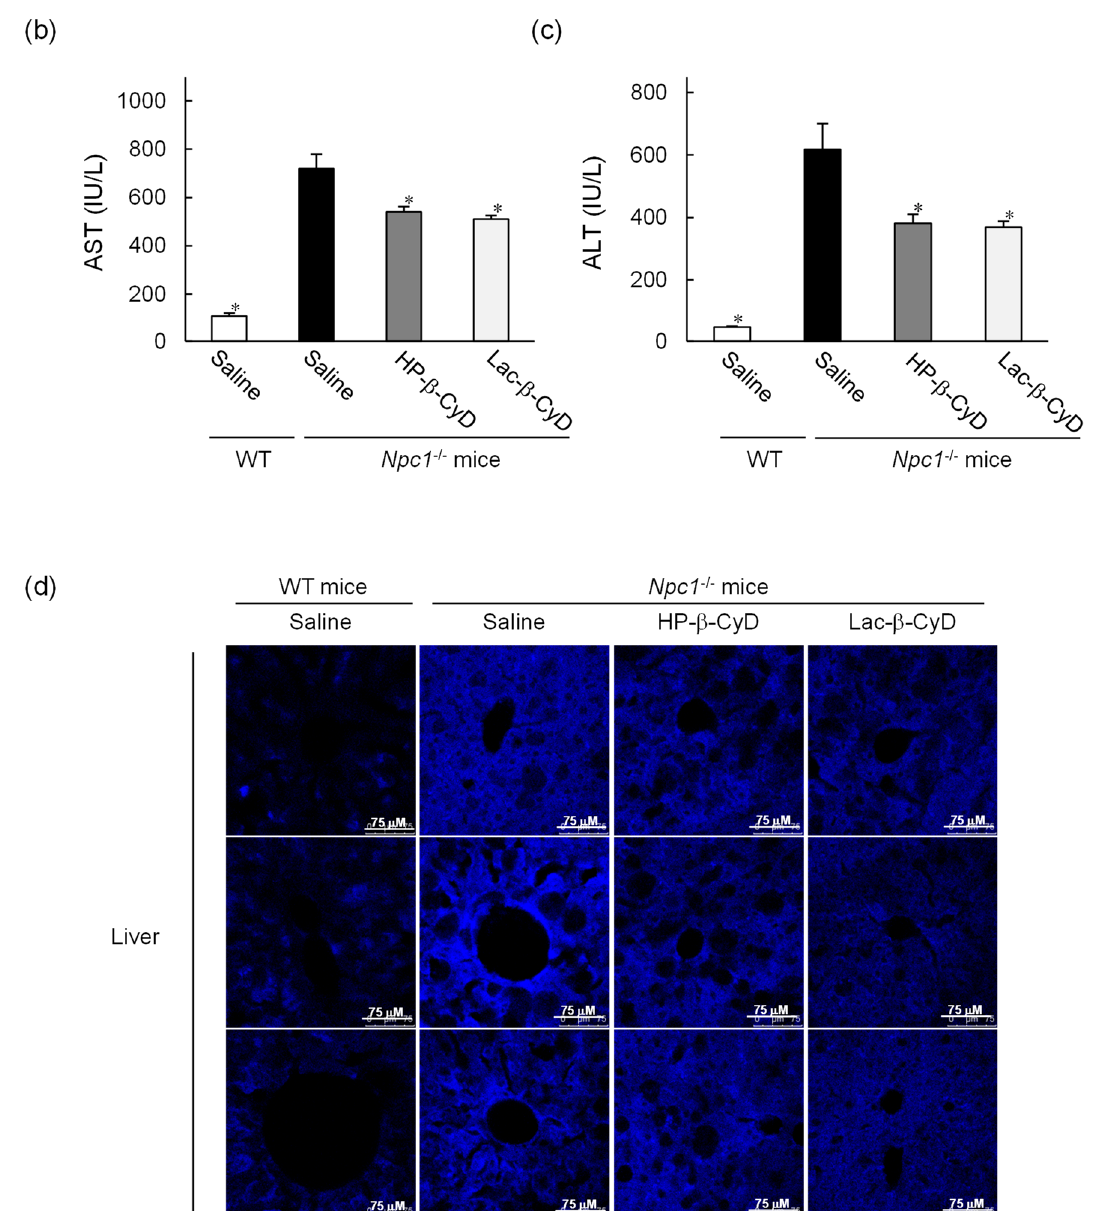
Figure 2. Therapeutic effects of Lac- β -CyD in NPC model mice after a single subcutaneous administration. Lac- β -CyD (0.7 mmol/kg, 2,098 mg/kg), HP- β -CyD (0.7 mmol/kg, 1,000 mg/kg), or saline was administered to 8 week old WT and Npc1 –/– mice via a single subcutaneous injection. The blood and organs were collected 24 h later. ( a ) Histological analysis of liver, spleen, and kidneys of the Npc1 -/- mice. These figures show the representative images of 3 different mice. ( b , c ) AST (b) and ALT ( c ) levels in plasma. Each value represents the mean ± S.E.M. of 4-7 experiments. * p < 0.05, compared to control Npc1 -/- mice. ( d ) Free cholesterol accumulation in the liver of the Npc1 -/- mice. These figures show the representative images of 3 different mice.